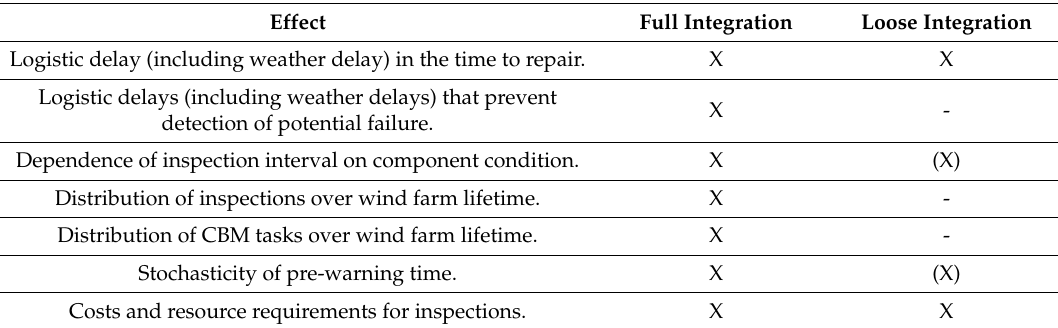
Table 1. Effects captured using full and loose integration of degradation processes. CBM, condition- based maintenance. Effect Full Integration Loose